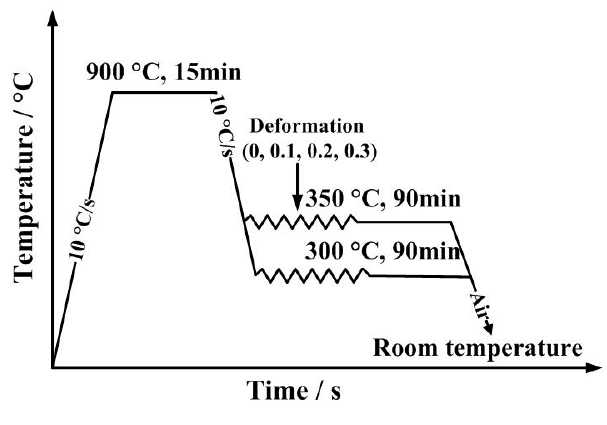
Figure 1. Experiment procedures.